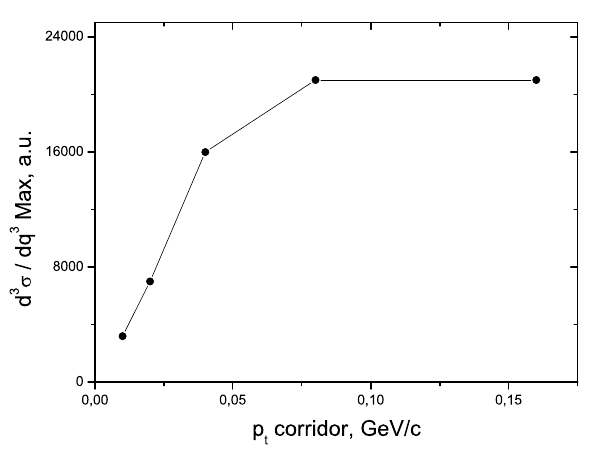
Figure 4. Maxima of 12 C ( d , p ) X spectra in dependence on p t